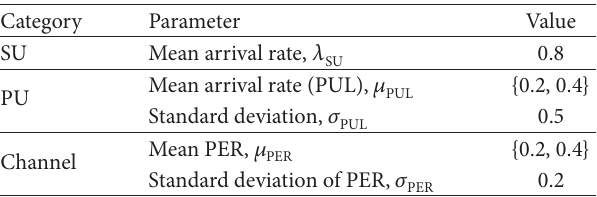
Table 4: Simulation parameters and values for investigating the effects of weight factor in reward representation.